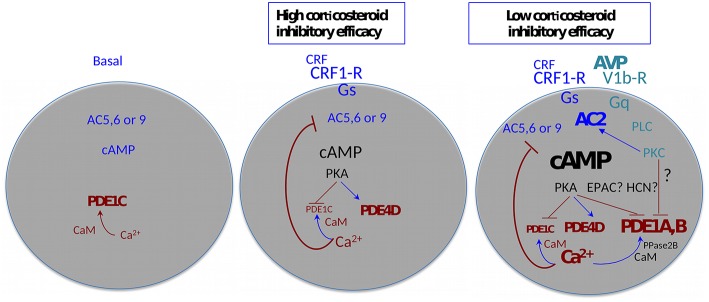
Agonist-induced plasticity of cAMP signaling—multiple functional states of the adenohypophysial corticotroph cell. AC, adenylyl cyclase; CaM, calmodulin; EPAC, exchange factors directly activated by cAMP; HCN, Hyperpolarization activated cyclic nucleotide gated channels; PDE- cyclic nucleotide phosphodiesterase; PKA, cAMP dependent protein kinase; PKC, protein kinase C; PLC, phospholipase C; PPase2B, protein phosphatase 2B (alias calcineurin). Arrows indicate facilitation, T-bars indicate inhibition. The size and thickness of the lettering is proportional to the amplitude/activity of the denoted entity.